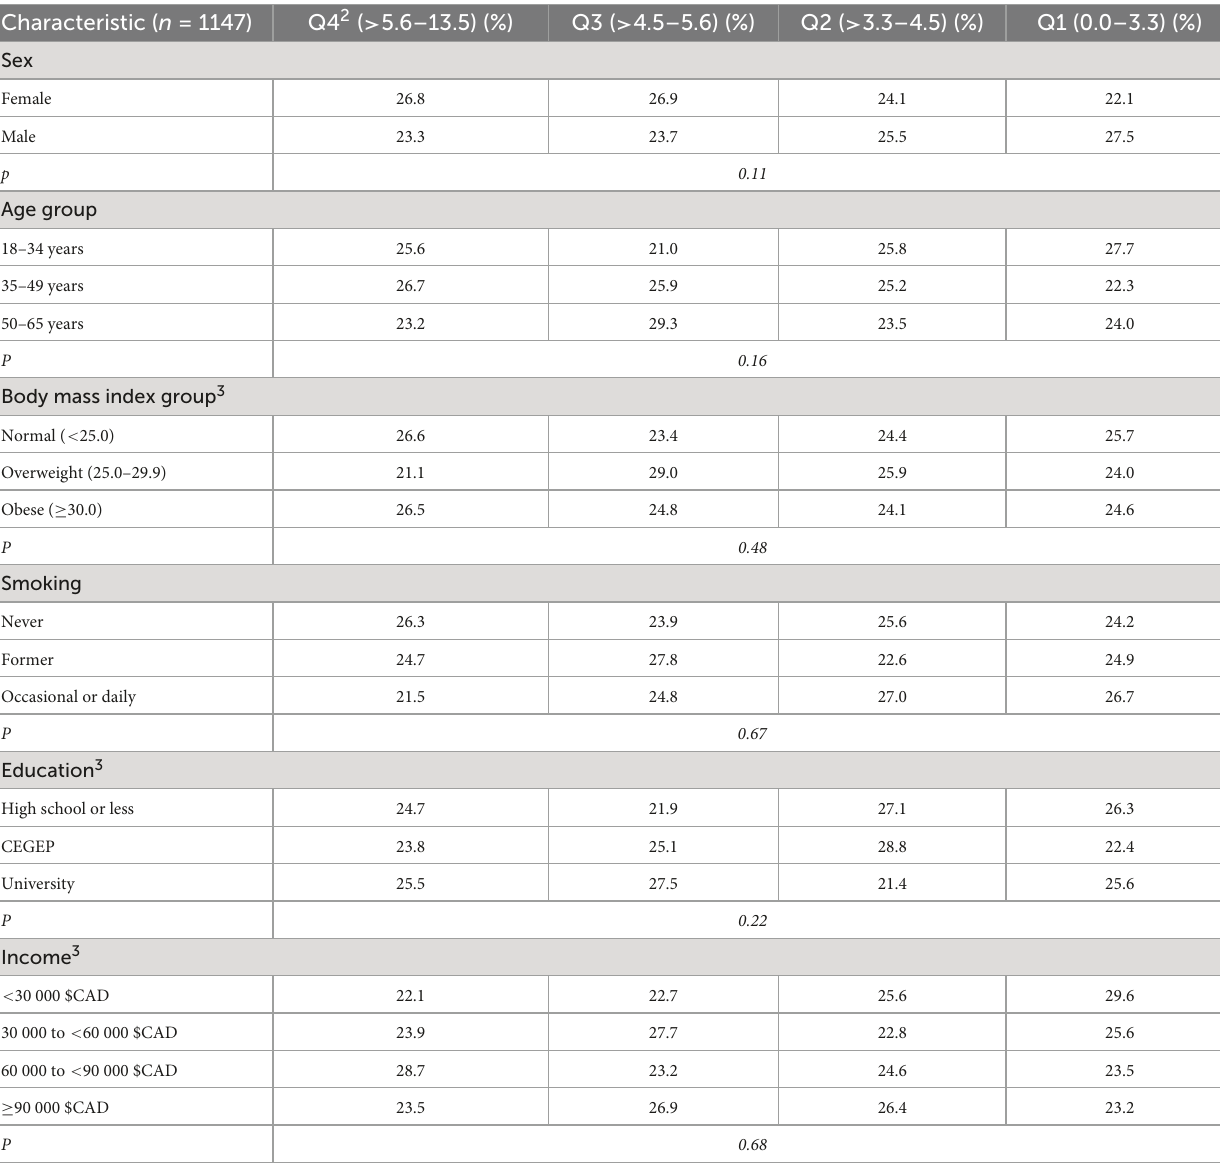
TABLE 1 Participants’ sociodemographic characteristics according to quarters of animal-based protein food intake 1 . Characteristic ( n =